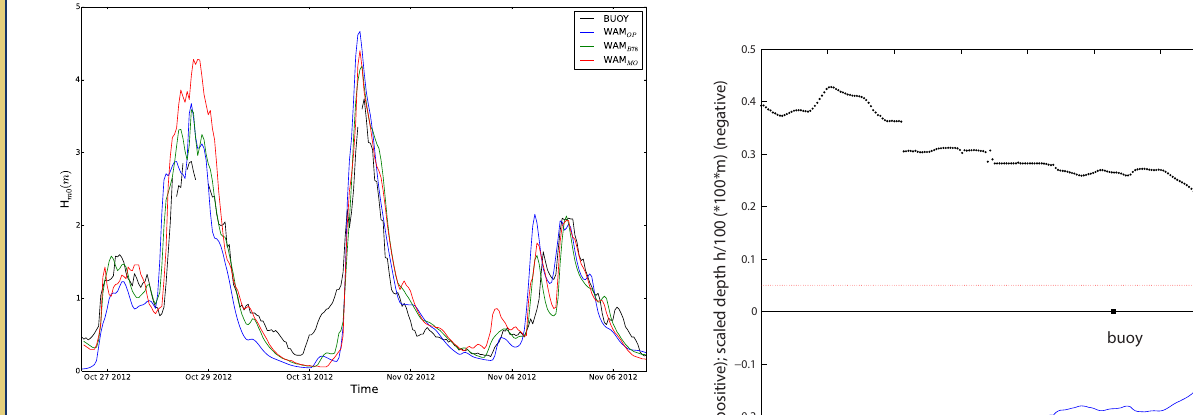
Figure 12. Test-case 1: comparison between forecast and buoy data at Venice buoy location.